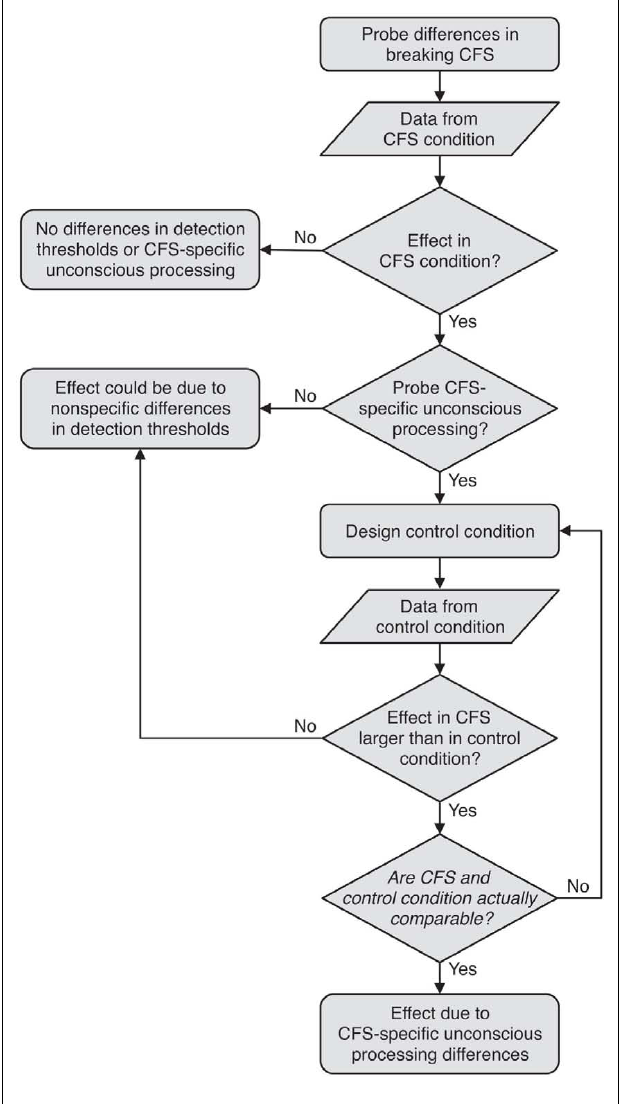
FIGURE 1 | Flowchart illustrating the logic underlying the b-CFS paradigm. If no control condition is included, no conclusions about CFS-specific unconscious processing differences can be drawn, as the effect obtained under CFS could be due to non-specific differences in detection thresholds. From the comparison of the effect obtained under CFS to the effect obtained in the control condition, CFS-specific unconscious processing can only be inferred if (a) the effect in the CFS condition is larger than the effect in the control condition, and, critically, (b) the CFS and the control condition are actually comparable in the sense that the control condition emulates all processes that are not CFS-specific, but were involved in mediating a difference in stimulus detection in the CFS